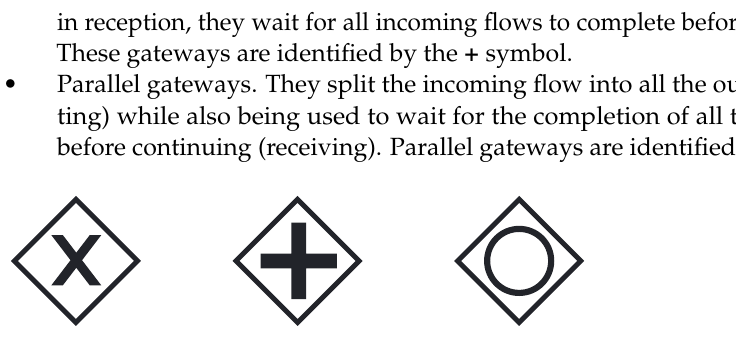
Figure 4. BPMN shapes for gateways branches before continuing (receiving). Parallel gateways are identified by a circle 176 symbol. 177